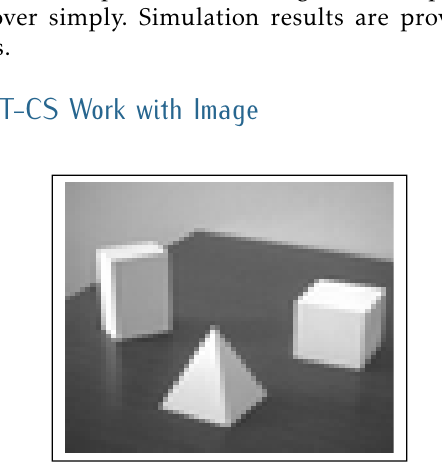
Figure 3. An example of an image to be compressed and reconstruct